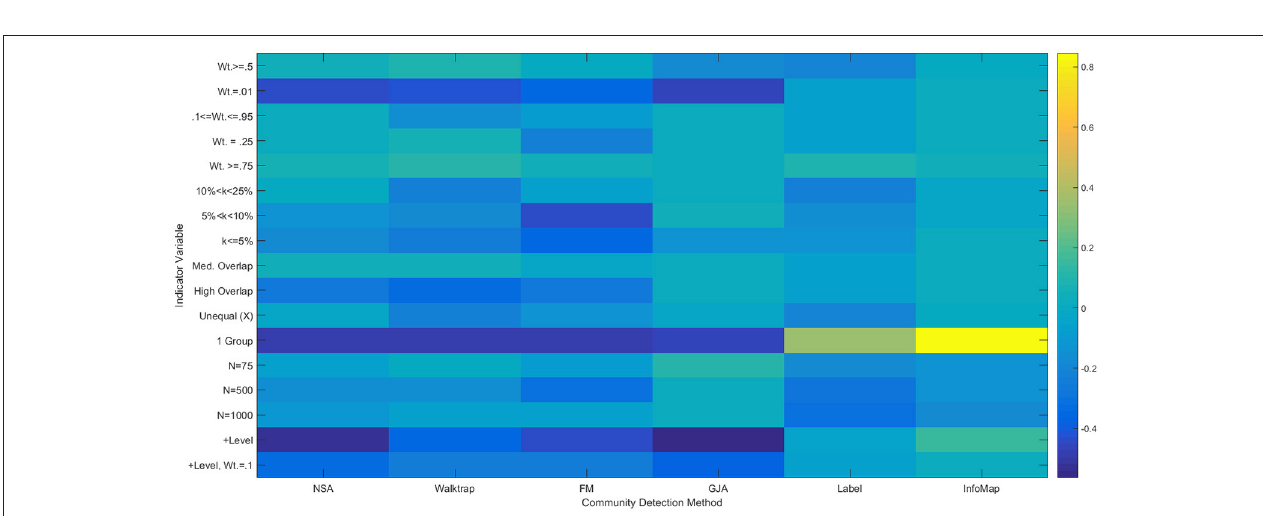
FIGURE 7 | Heatmap of Multiple Regression Results for Reflected Euclidean Matrices. Standardized betas are depicted from multiple regressions conducted for each method using the condition indicator variables to predict ARI HA . “Wt.” = indegree connectivity weight; “k” refers to the proportion of the sample in each community; “Med” = Medium; “Unequal” refers to unequal community sizes; “N” refers to graph size. Reference category is: N = 25, equally sized communities, low overlap, each community containing at least 25% of the sample, and indegree weight between 0.25 and